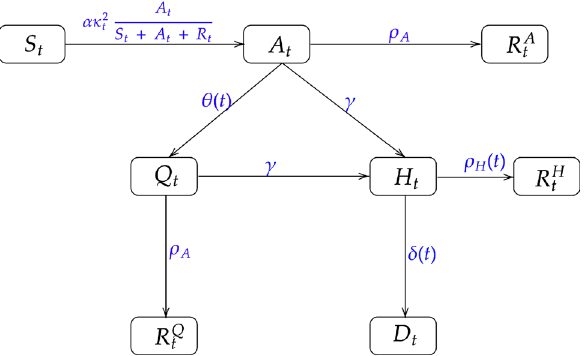
Q , R A , R H t t t